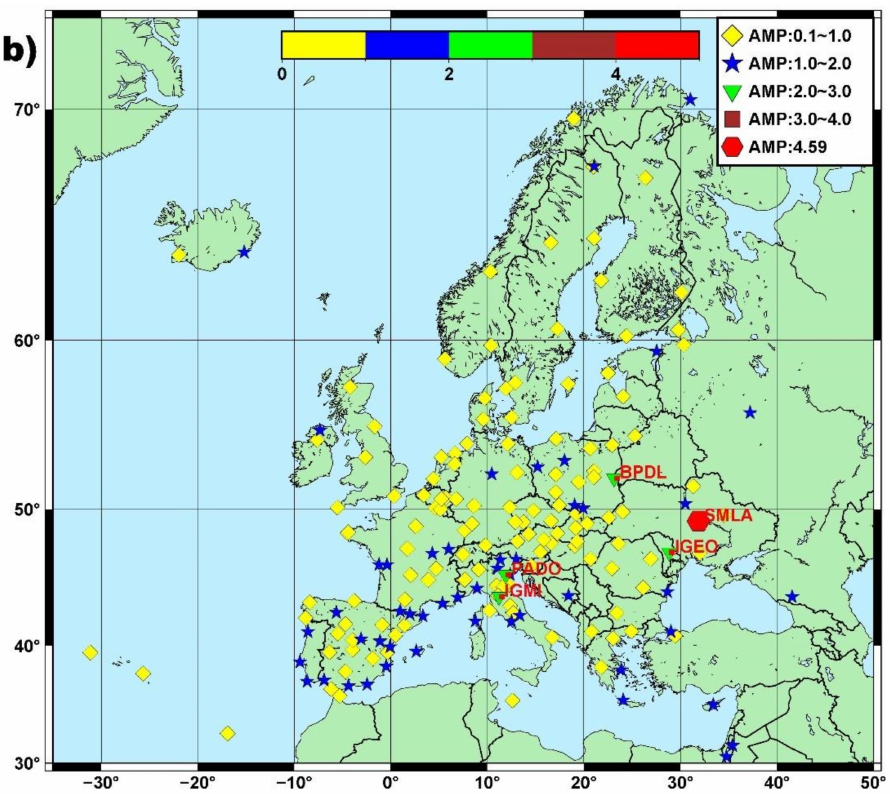
Figure 1. Seasonal amplitude for the ( a ) East component and ( b ) North component of all